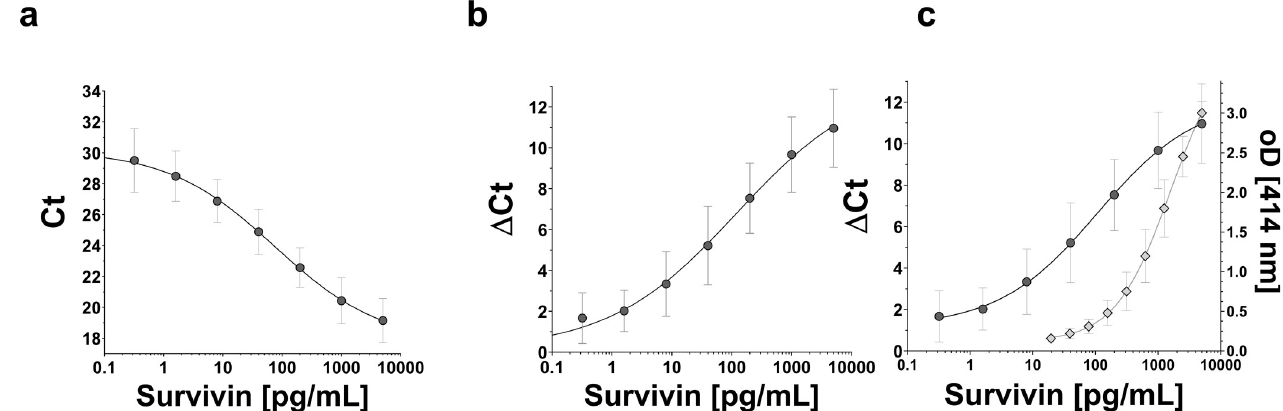
Fig 1. Reference curve of the survivin spPLA based on 40 independent experiments. Survivin concentrations ranged from 0.32 pg/mL to 5000 pg/mL. ( a ) Raw Ct-values versus survivin concentrations. ( b ) Delta Ct-values versus survivin concentrations. ( c ) Comparison of spPLA (solid) and ELISA (dotted, mean of 44 independent experiments) for survivin